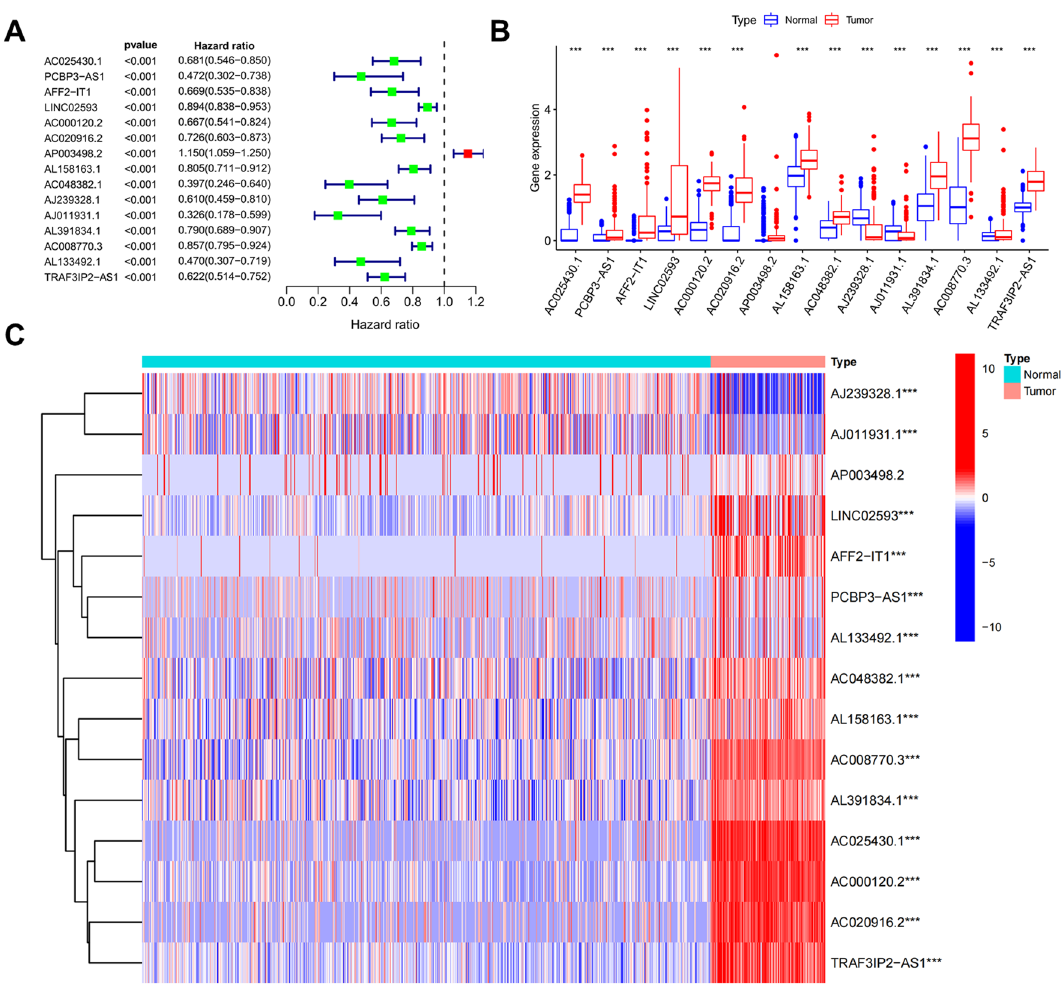
Figure 2. Prognostic analyses of m 6 A-related lncRNAs and expression of related factors. ( A ) Forest plot, showing 15 m 6 A-related lncRNAs associated with the overall survival rate of AML patients, constructed based on univariate Cox regression analysis. ( B , C ) Box plot and heatmap showing the overall and single-sample expression of m 6 A-related prognostic lncRNAs, respectively, in tumor and normal samples. *P < 0.05, **P < 0.01, ***P <